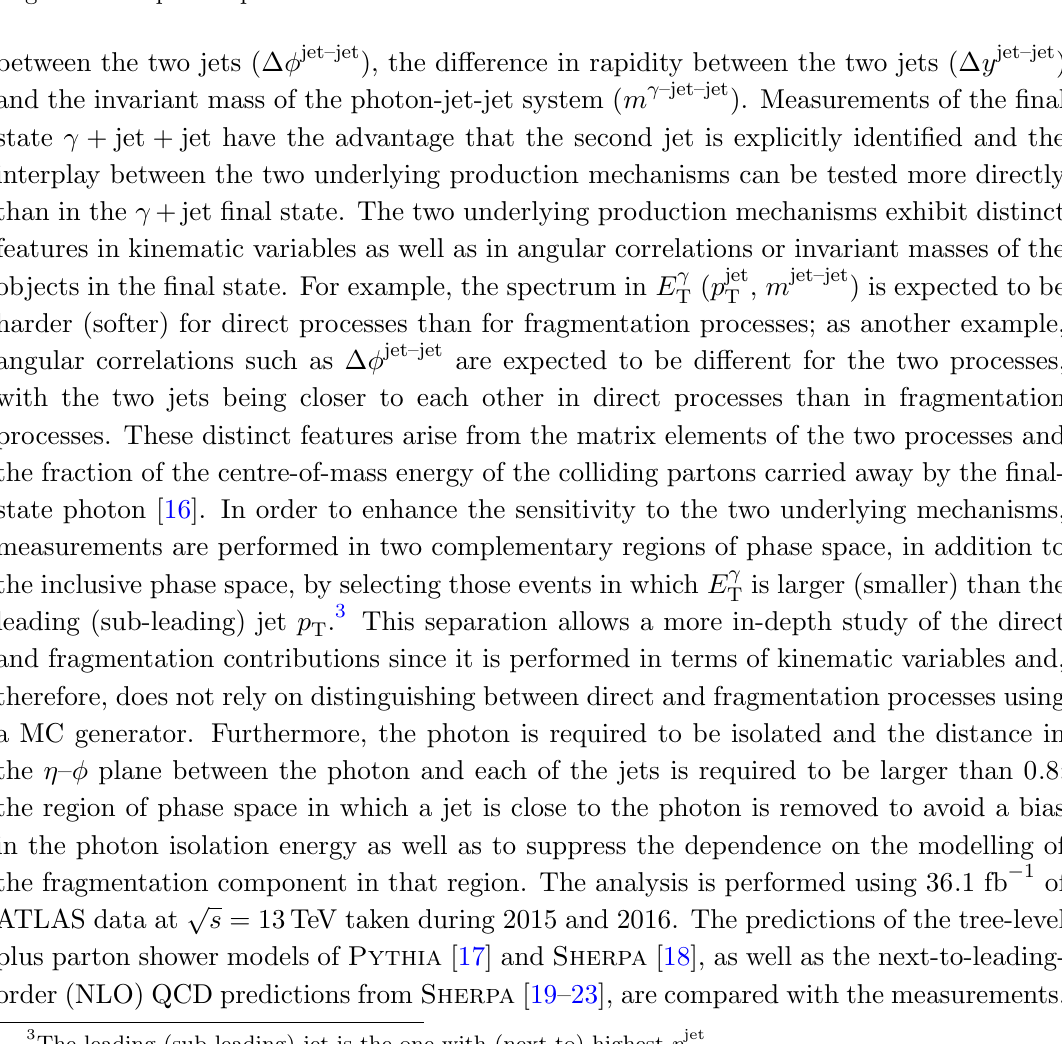
Figure 1 . Examples of diagrams for (cid:13) + jet + jet production through (a) direct-photon and (b) fragmentation-photon